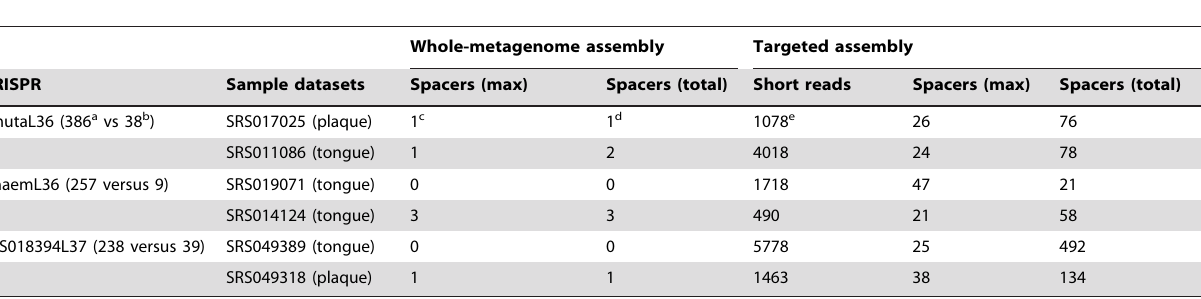
Table 2. Comparison of CRISPR identification using whole-metagenome assembly and targeted assembly.